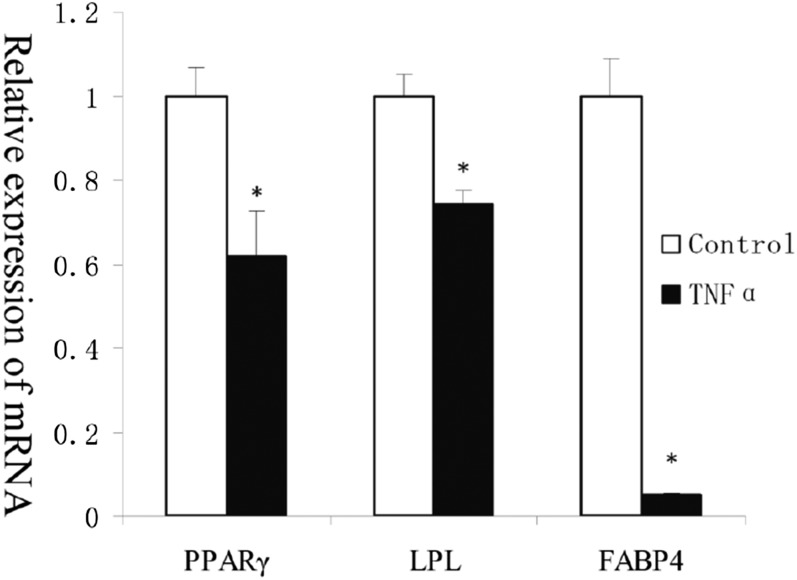
TNF-α inhibits expression of mature adipocyte markers during induced adipogenesis. Preadipocytes were treated with a 100 ng/ml dose of TNF-α, and cells were collected on induction day 8. mRNA expression levels of FABP4, PPARγ, and LPL were tested with quantitative RT-PCR method. These mature adipocyte markers were significantly decreased during induced adipogenesis with addition of TNF-α. Each sample was assayed in duplicate (* P < 0.05, n = 5).